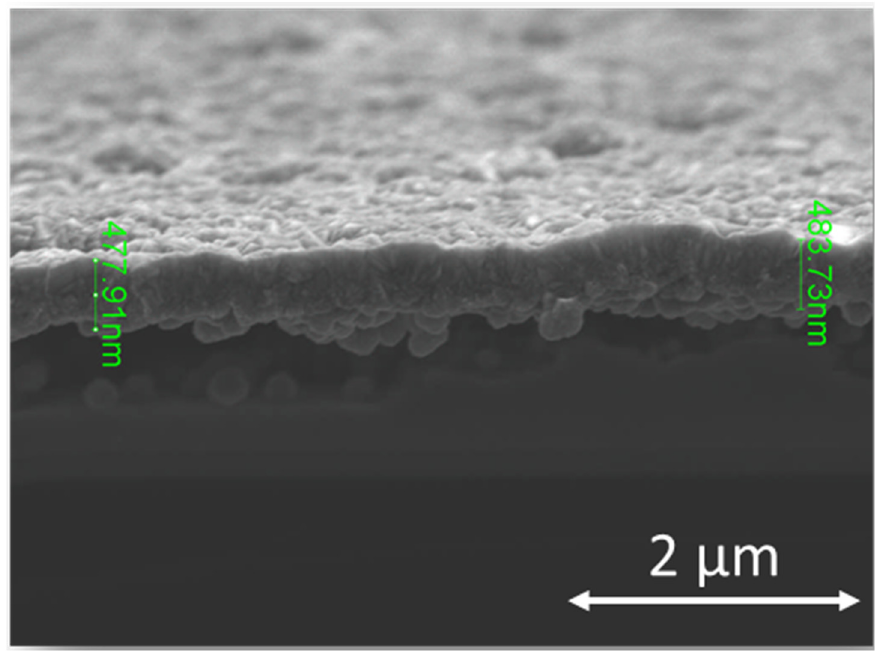
Figure 1. SEM cross-section of boron-doped diamond film deposited on e:GaN with B/C ratio 7000 ppm. The surface morphology of the prepared samples was investigated by AFM. Figure 2 shows nanoscale images of the height variations and mechanical properties of the B- doped polycrystalline films on GaN epilayers taken using the AFM method in PF-QNM